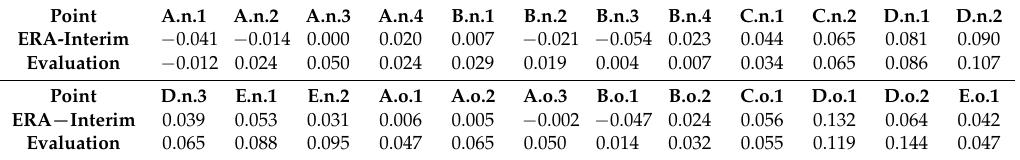
Table 5. Linear trend (m/s per decade) values computed for all 24 points for recent past